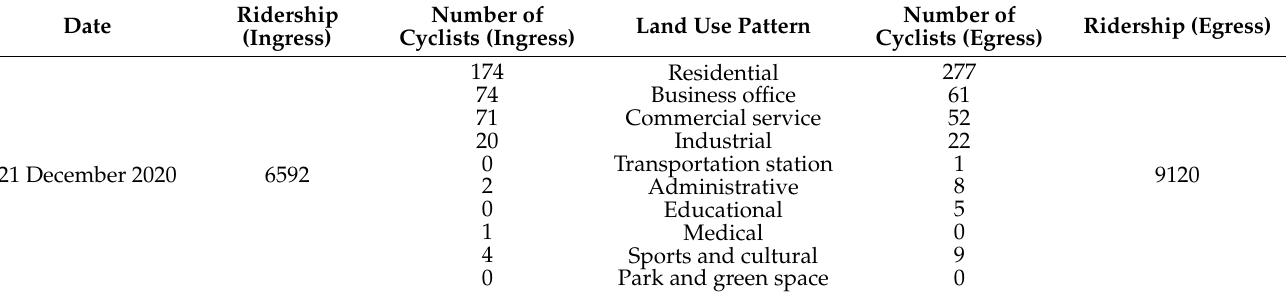
Table A1. The number of urban rail ridership and